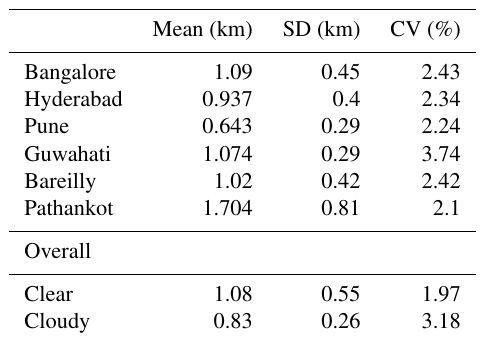
Table 2. Mean, SD, and coefficient of variation of the CBL at each station and for clear and cloudy